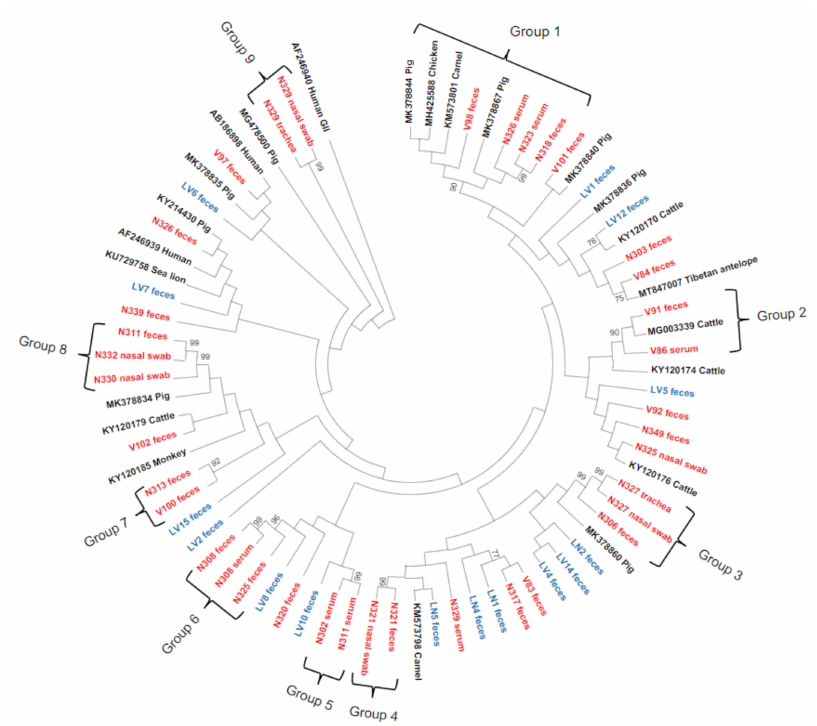
Figure 3. Phylogenetic analysis of partial RdRp gene of PBVs GI discovered in the present study. The tree was constructed using the maximum-likelihood method and the optimal substitution model of T92+G+I and rooted with genogroup II human strain AF246940. Two hundred and 43 nucleotide positions were included in the analysis. Bootstrap values below 70% are not shown. Deer sequences are highlighted in red and cattle sequences in